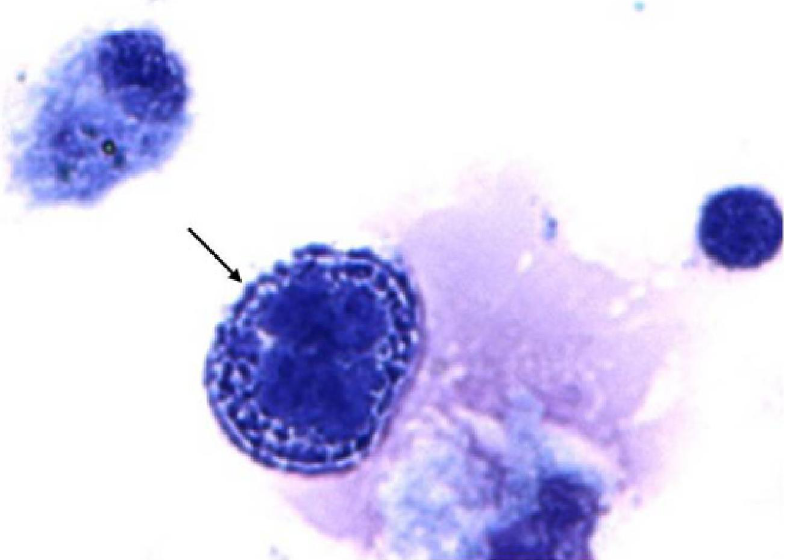
Figure 3. Cytology of a patient with PVRL showing a large atypical lymphoid cell (arrow) with large nuclei, prominent nucleoli, and scanty basophilic cytoplasm in the vitreous specimen (Giemsa, original magnification, ×640).